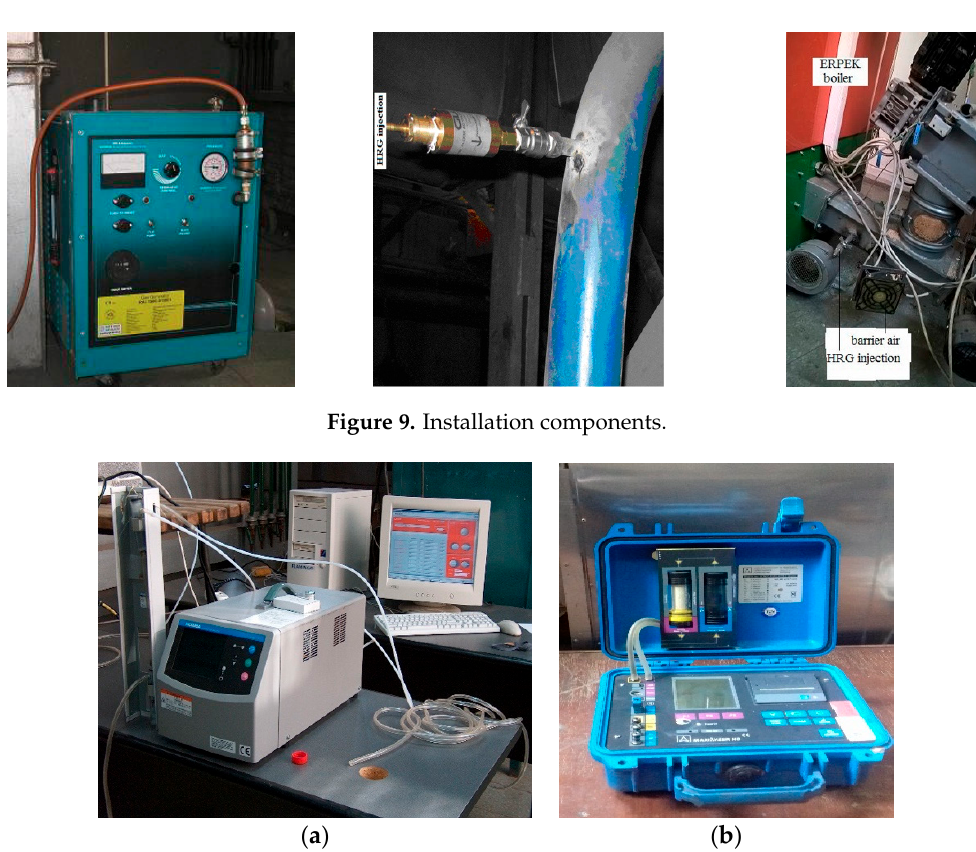
Figure 9. Installation components.